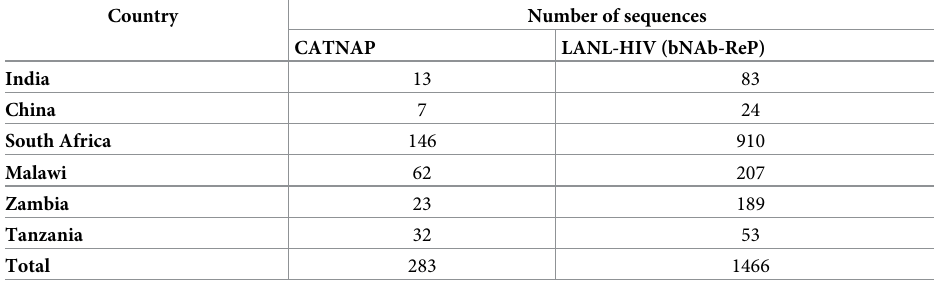
Table 2. Details of sequences analyzed, and their sources used for predication analysis of HIV-1 subtype C to dif- ferent bnAbs.